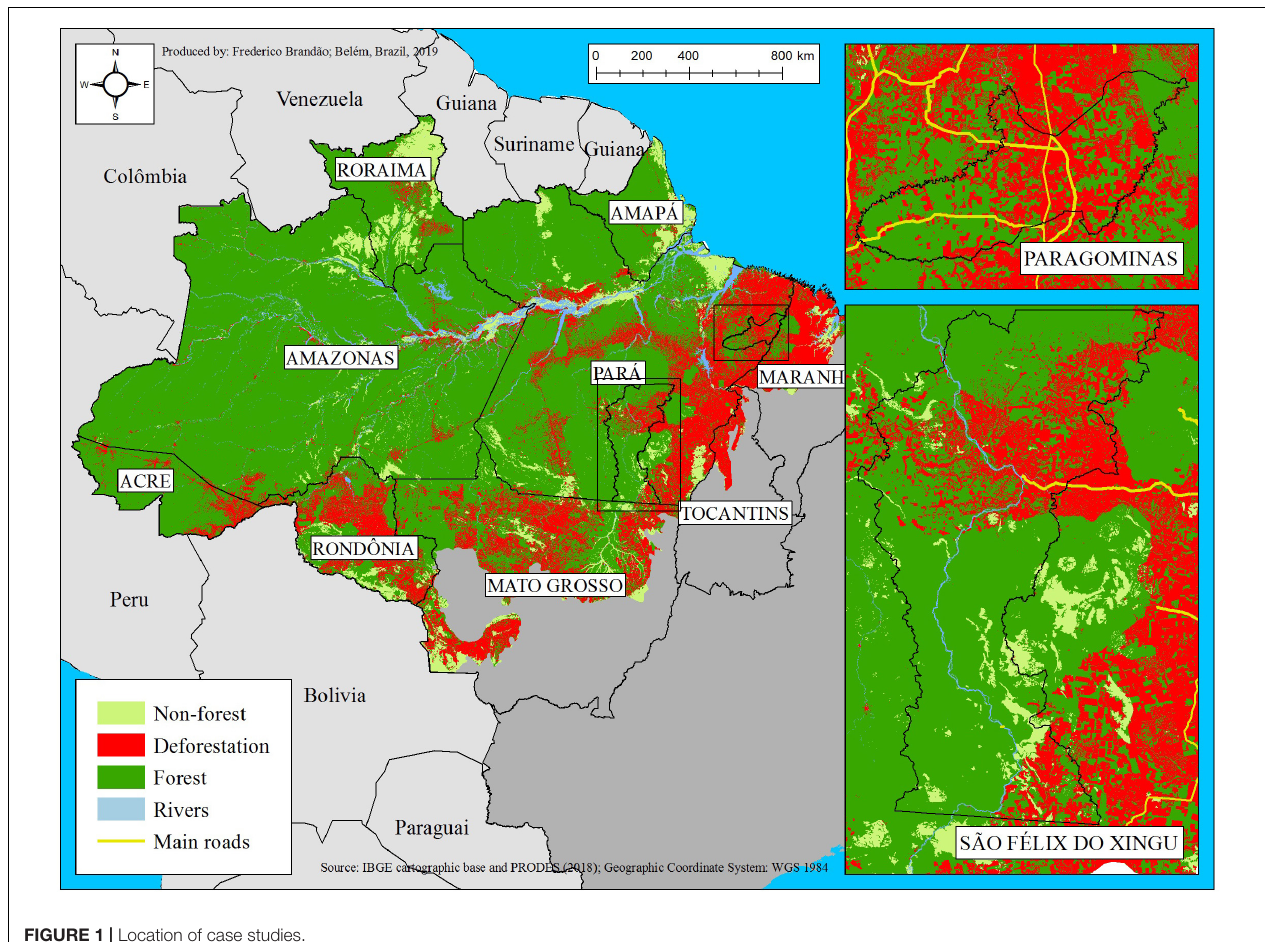
FIGURE 1 | Location of case studies. TABLE 2 | Comparison of the context in Paragominas and São Félix do Xingu. Similarities Differences History of violence and absence of